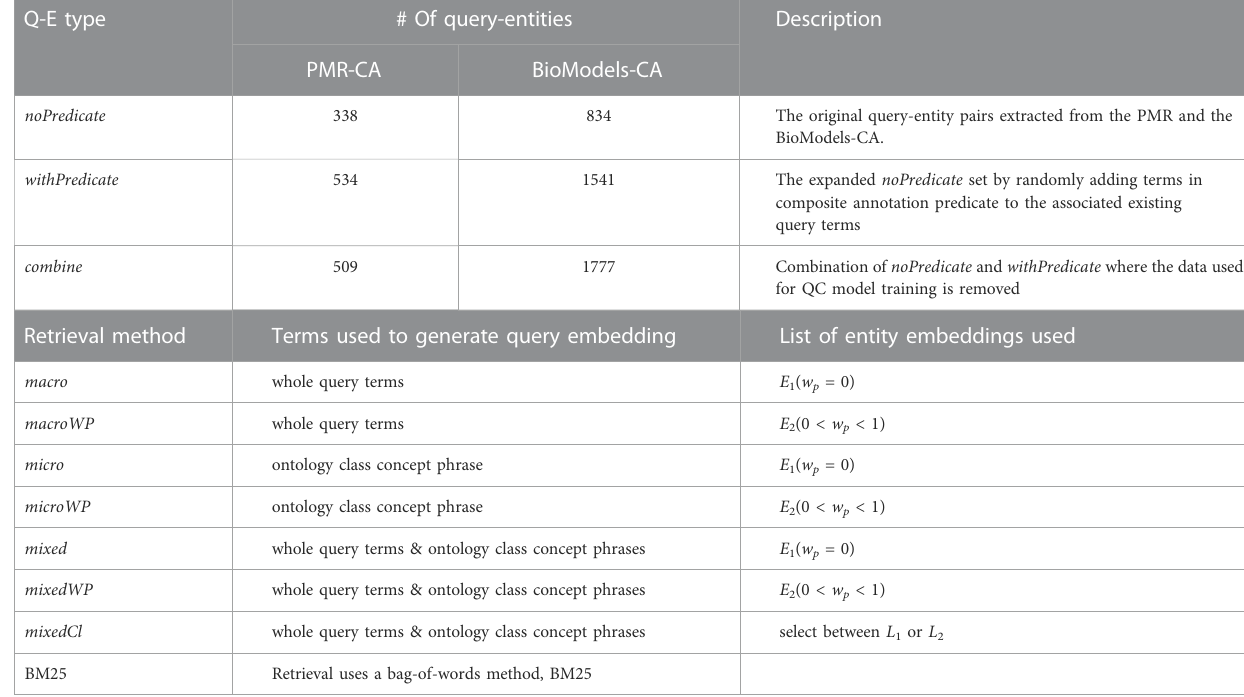
TABLE 2 The strategies to measure CASBERT performance. There are three query sets and eight retrieval methods including BM25 as the gold